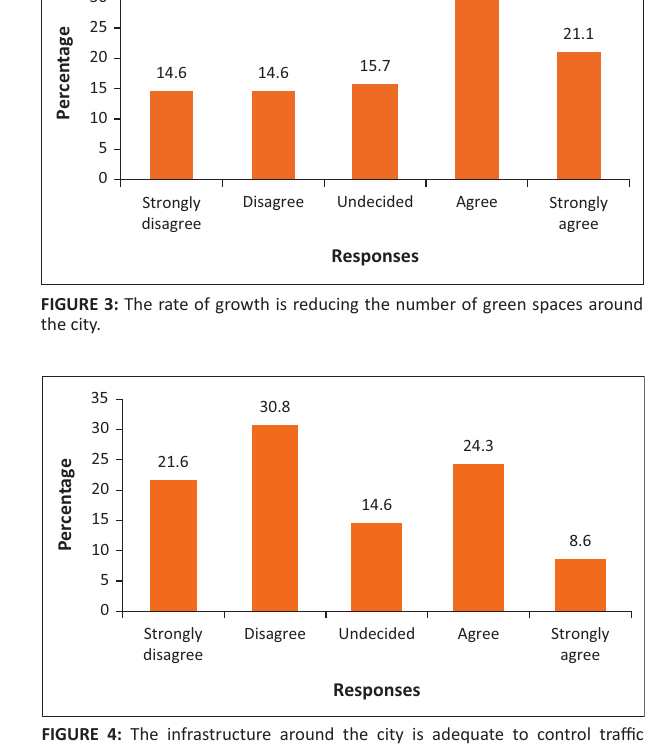
FIGURE 2: The top-down approach to urban planning.